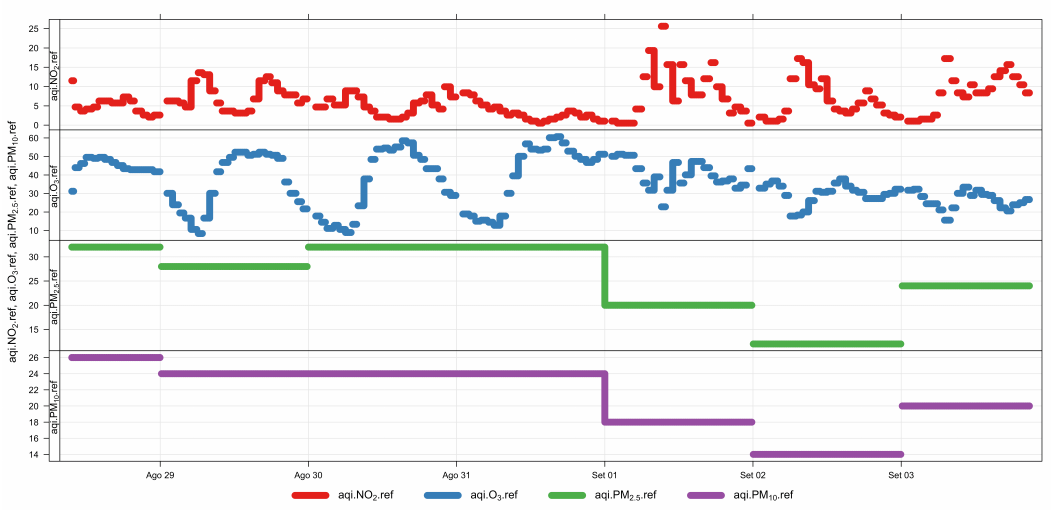
Figure 6. Time series of the AQIs resulting from the reference measurements for NO 2 , O 3 and